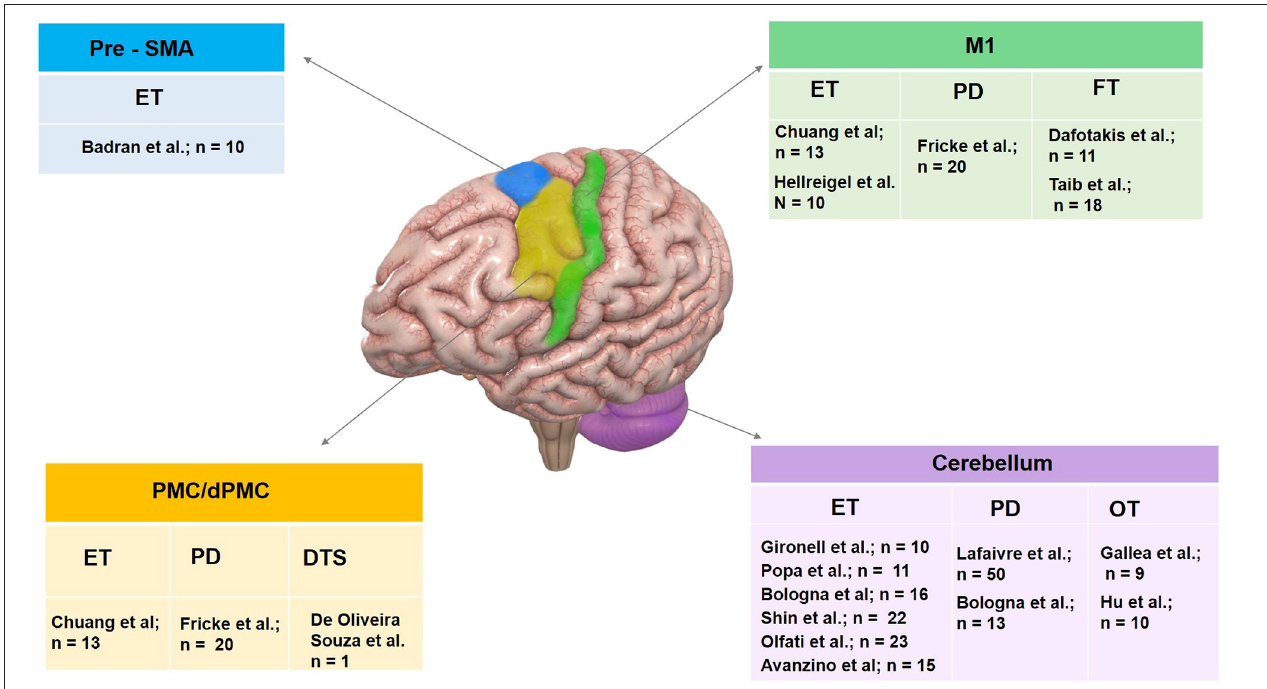
FIGURE 3 | Summary of therapeutic use of rTMS in tremor syndromes organized by target site. Pre-SMA, pre supplementary motor area; M1, primary motor cortex; PMC, premotor cortex and cerebellum have been targeted. Investigator group and sample size enrolled for individual tremor syndrome including essential tremor (ET), Parkinson’s disease (PD) tremor, dystonic tremor syndrome (DTS), orthostatic tremor (OT) and functional tremor (FT) are